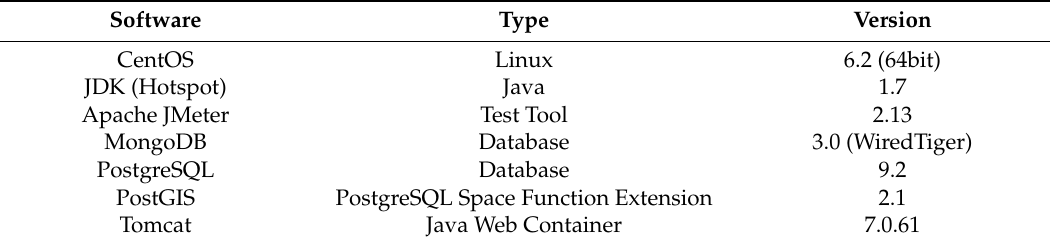
Table 2. Software Test Environment.